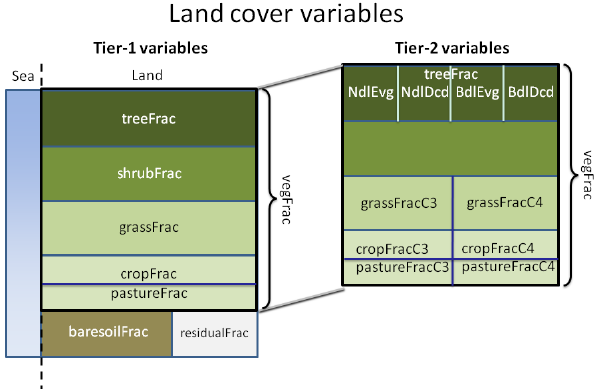
Figure 12. Fire and wetland variables. Other than burntFractionAll, all other variables are requested as tier 2